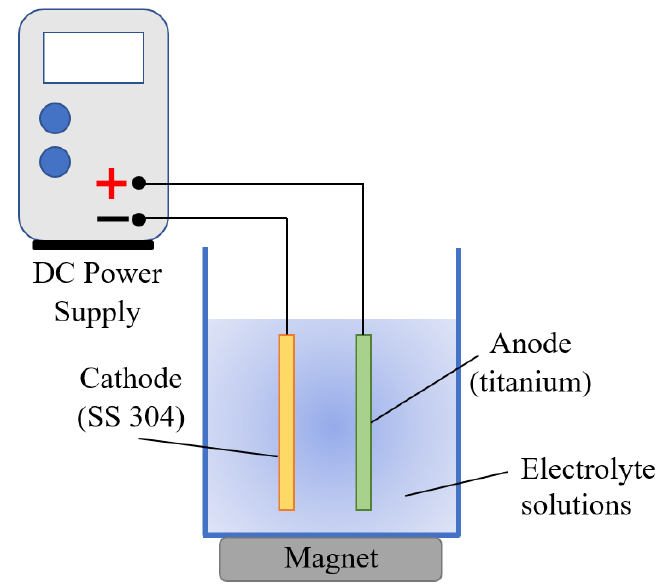
Figure 1. Experimental setup of electropolishing. Table 5. The experimental parameters applied in this research.